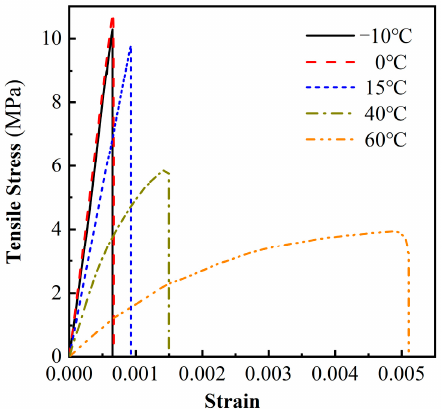
Figure 13. Stress-strain curves of MPUC at different temperatures.